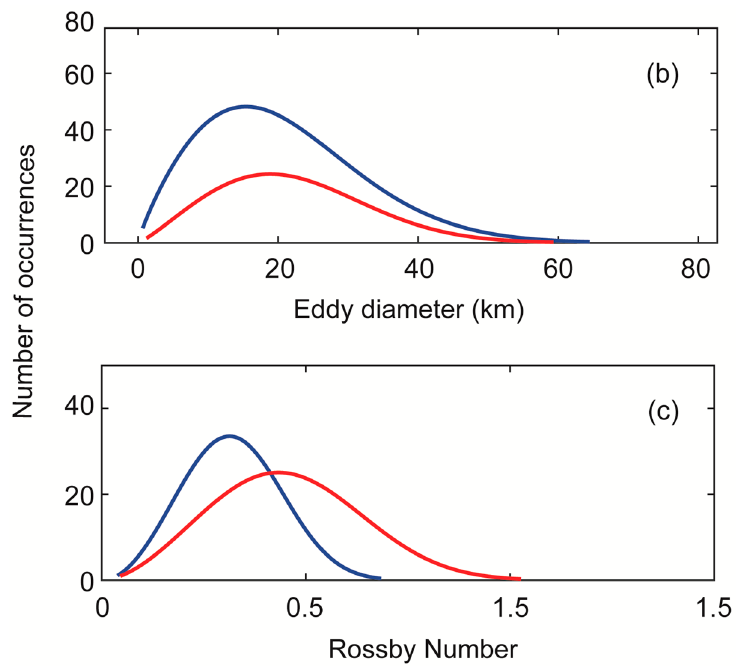
Figure 12. ( a ) Shapes and locations of persistent (lifespan longer than 1 day) eddies along the study region; ( b ) probability density distribution (pdf) curves for eddy diameters (km); ( c ) probability density distribution (pdf) curves for Rossby number (R o ; Equation (8)). Blue and red curves represent counterclockwise (CCW) and clockwise (CW) eddies.